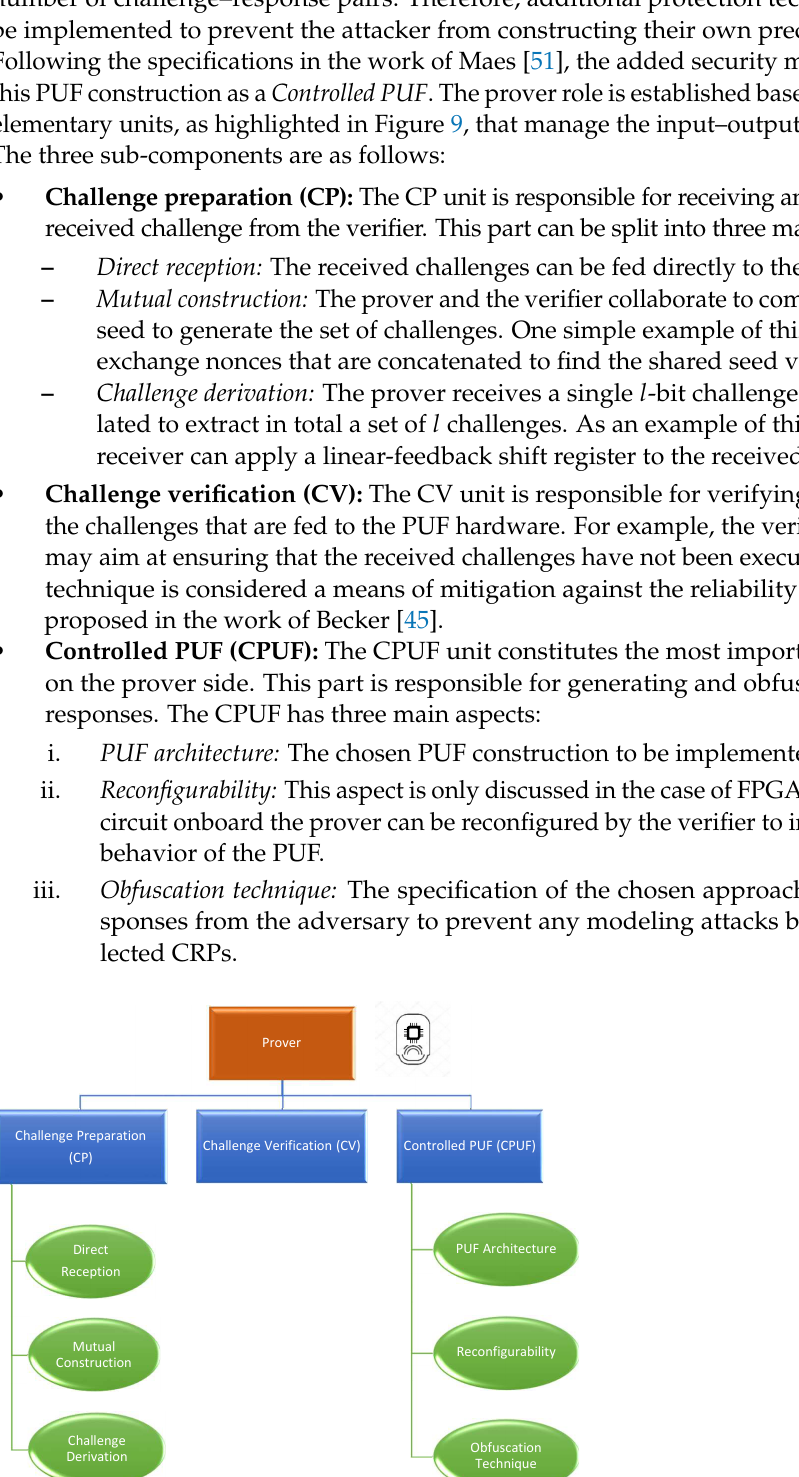
Figure 9. Key elements of the prover